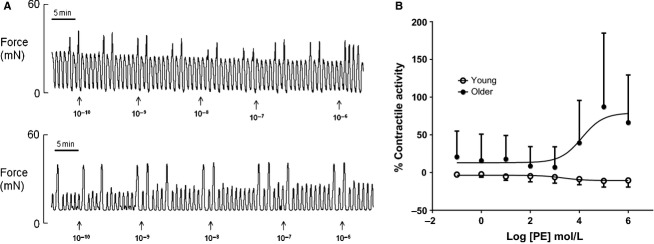
Effects of phenylephrine on uterine activity. (A) Representative recordings of uterine contractions in a YOUNG (top trace) and OLDER (bottom trace) rat dam incubated with accumulative concentrations of Phenylephrine (range 0.1 nmol/L to 1 μmL/L, units shown are in log mol/L). (B) A dose–response curve to determine the effects of maternal age, YOUNG (n = 4) or OLDER (n = 7) on uterine integral activity to increasing doses of phenylephrine (range 0.1 nmol/L to 1 mmol/L, units shown are in log mol/L). Statistical analysis reveals that the dose–response curves were significantly different (P < 0.0001). LogEC50 was significantly shifted by maternal age, YOUNG logEC50 = 3.34, OLDER logEC50 =4.1.